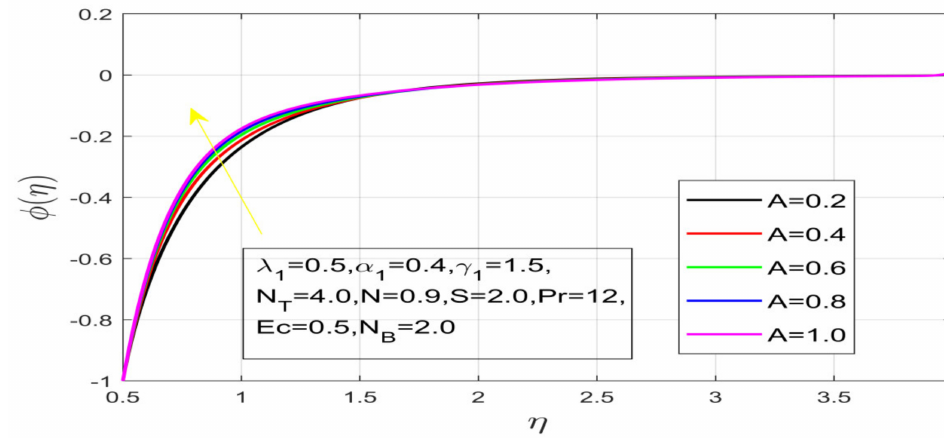
Figure 15. Contact of Pr on temperature.